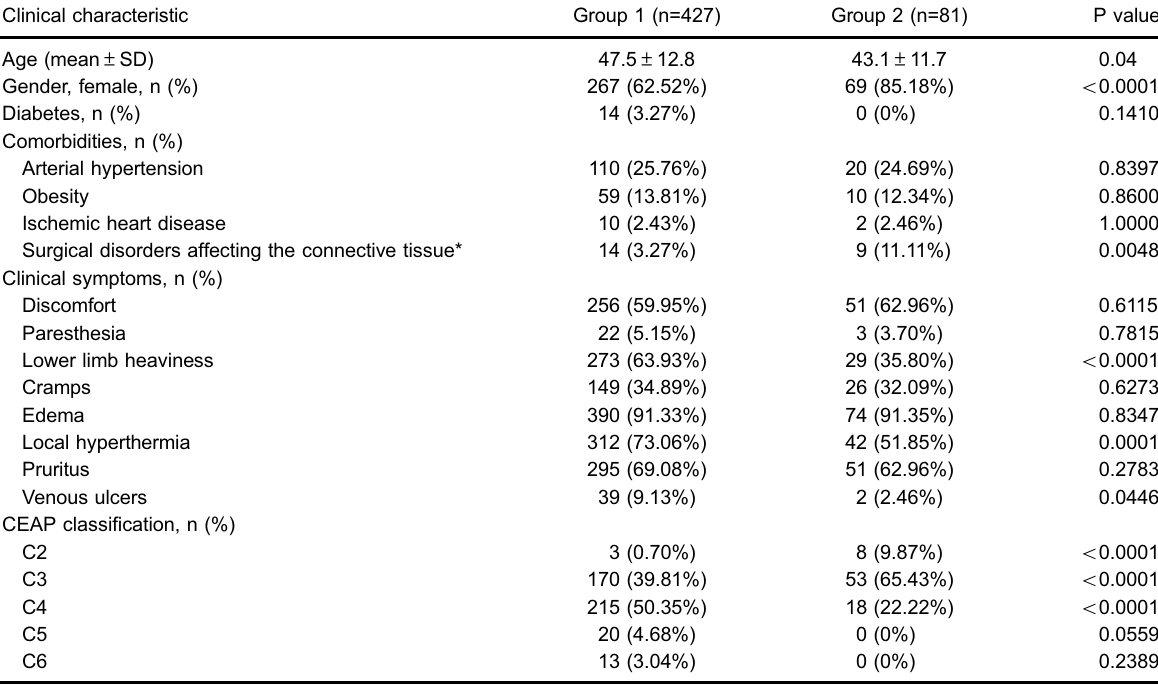
Table 1 . Baseline characteristics of the study population and CEAP (clinical, etiologic, anatomic, pathophysiologic) classi fi cation. Clinical characteristic